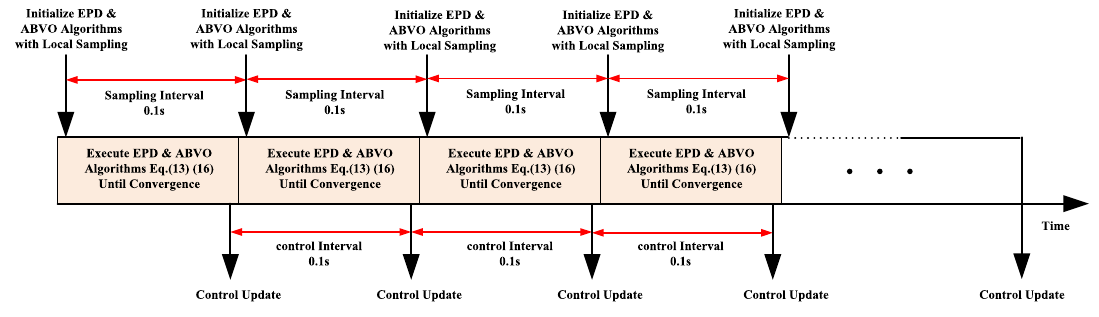
Figure 4. Implementation of the proposed control